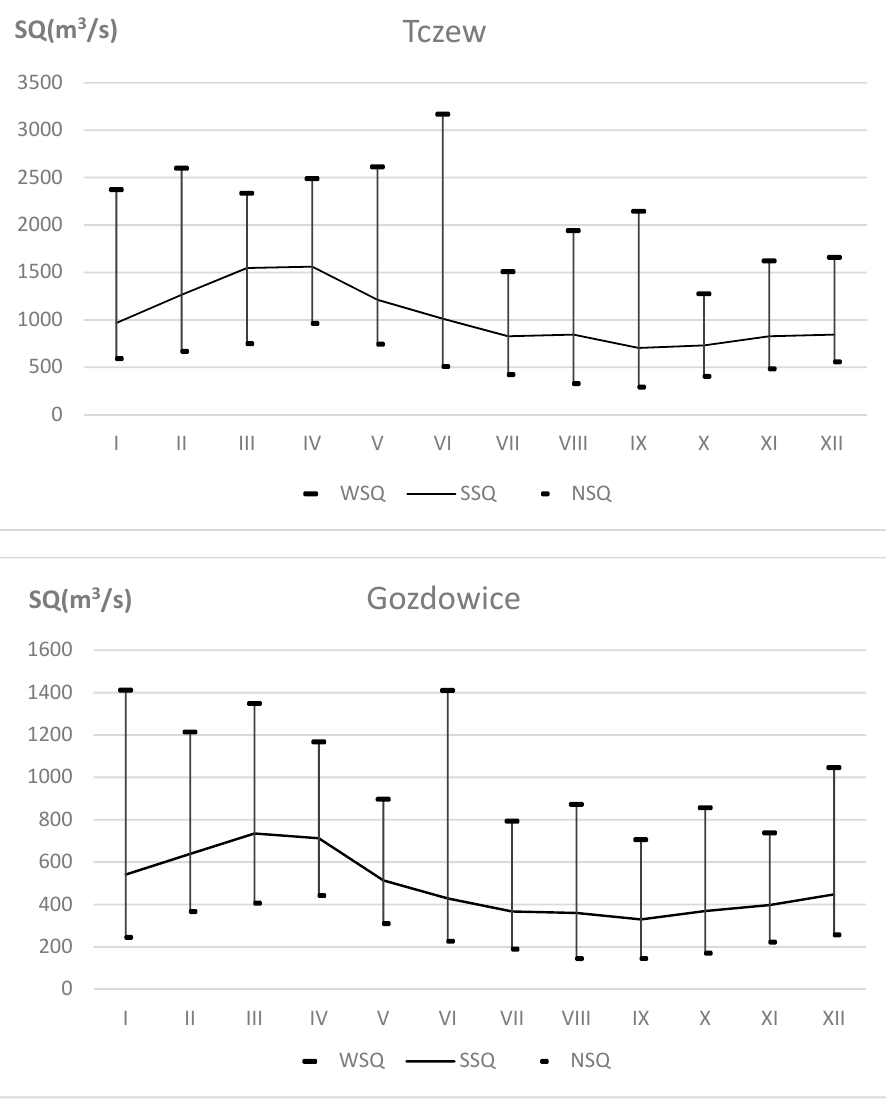
Figure 5. Maximum (WSQ), average (SSQ) and minimum (NSQ) monthly flows of the Vistula in Tczew and the Oder in Gozdowice in the period 1999–2018 (based on Institute of Meteorology and Water Management—National Research Institute data).